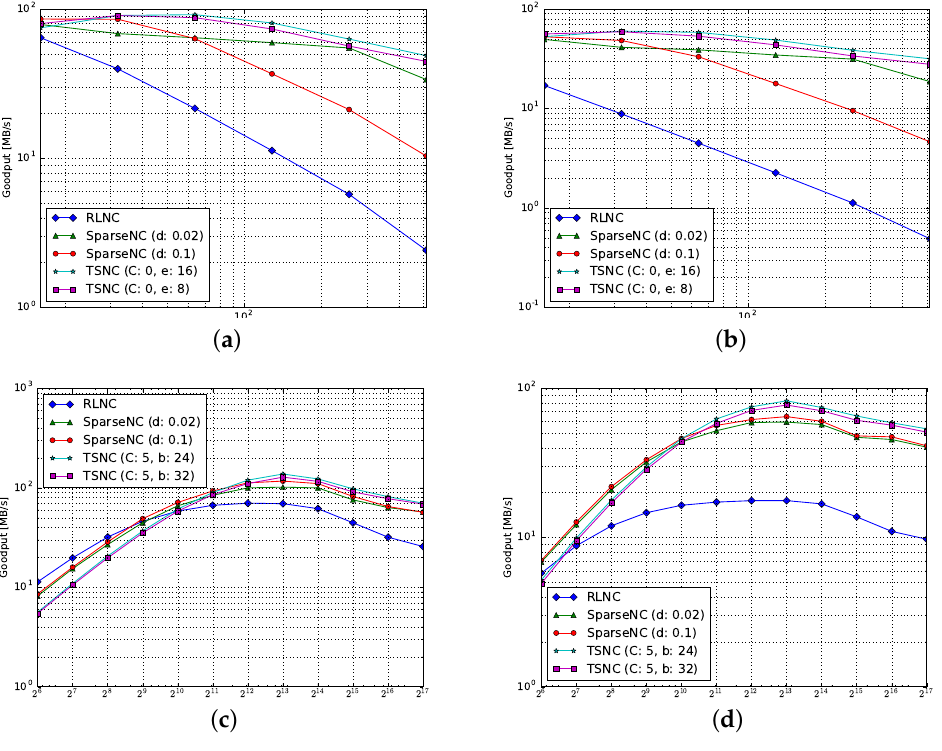
Figure 5. Encoder goodput measurements for the Raspi 2. ( a ) Goodput vs. generation size for q = 2; ( b ) goodput vs. generation size for q = 2 8 ; ( c ) goodput vs. packet size for q = 2, g = 16; ( d ) goodput vs. packet size for q = 2 8 , g =